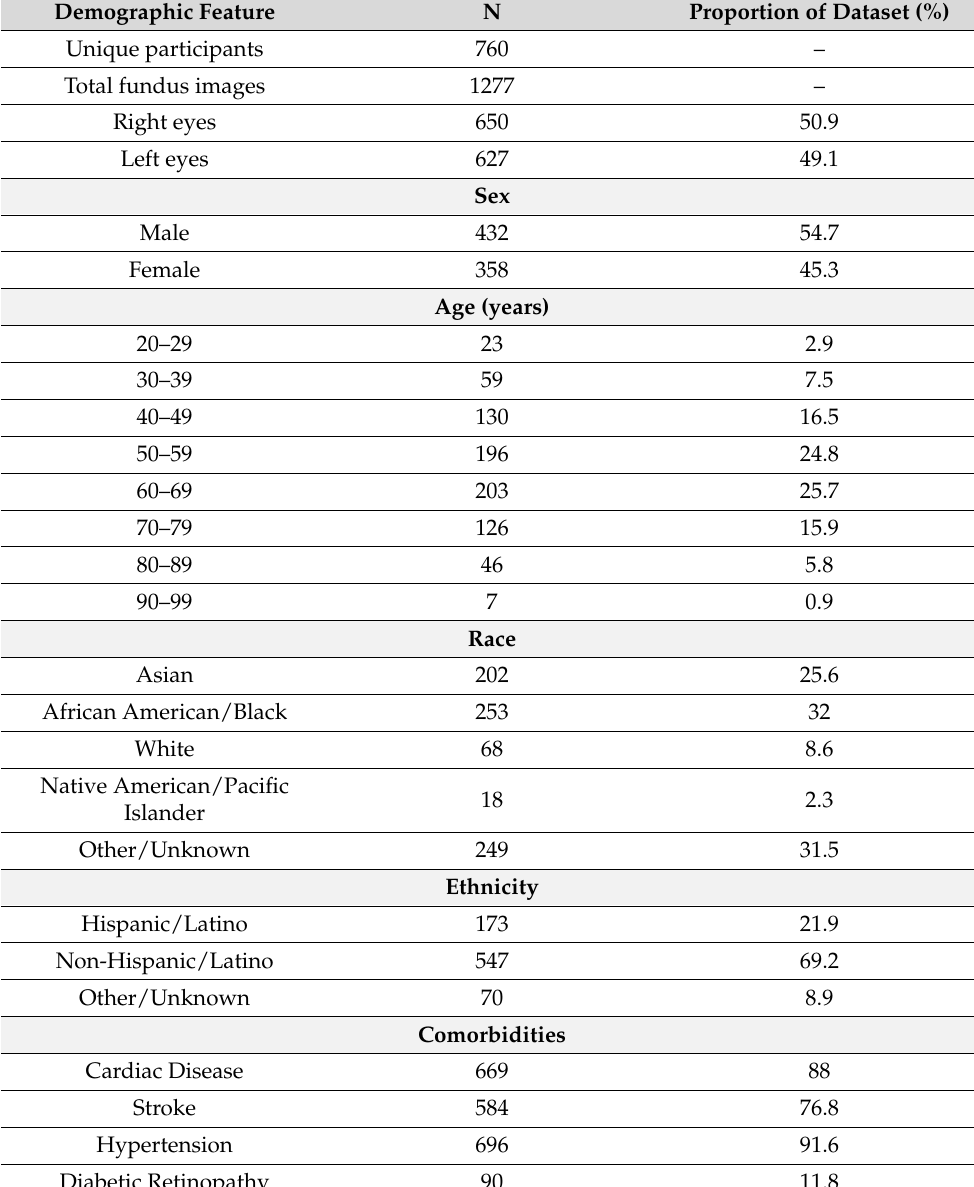
Table 1. Participant demographics. Information pertaining to patient age, sex, race, ethnicity, and comorbidity status are outlined